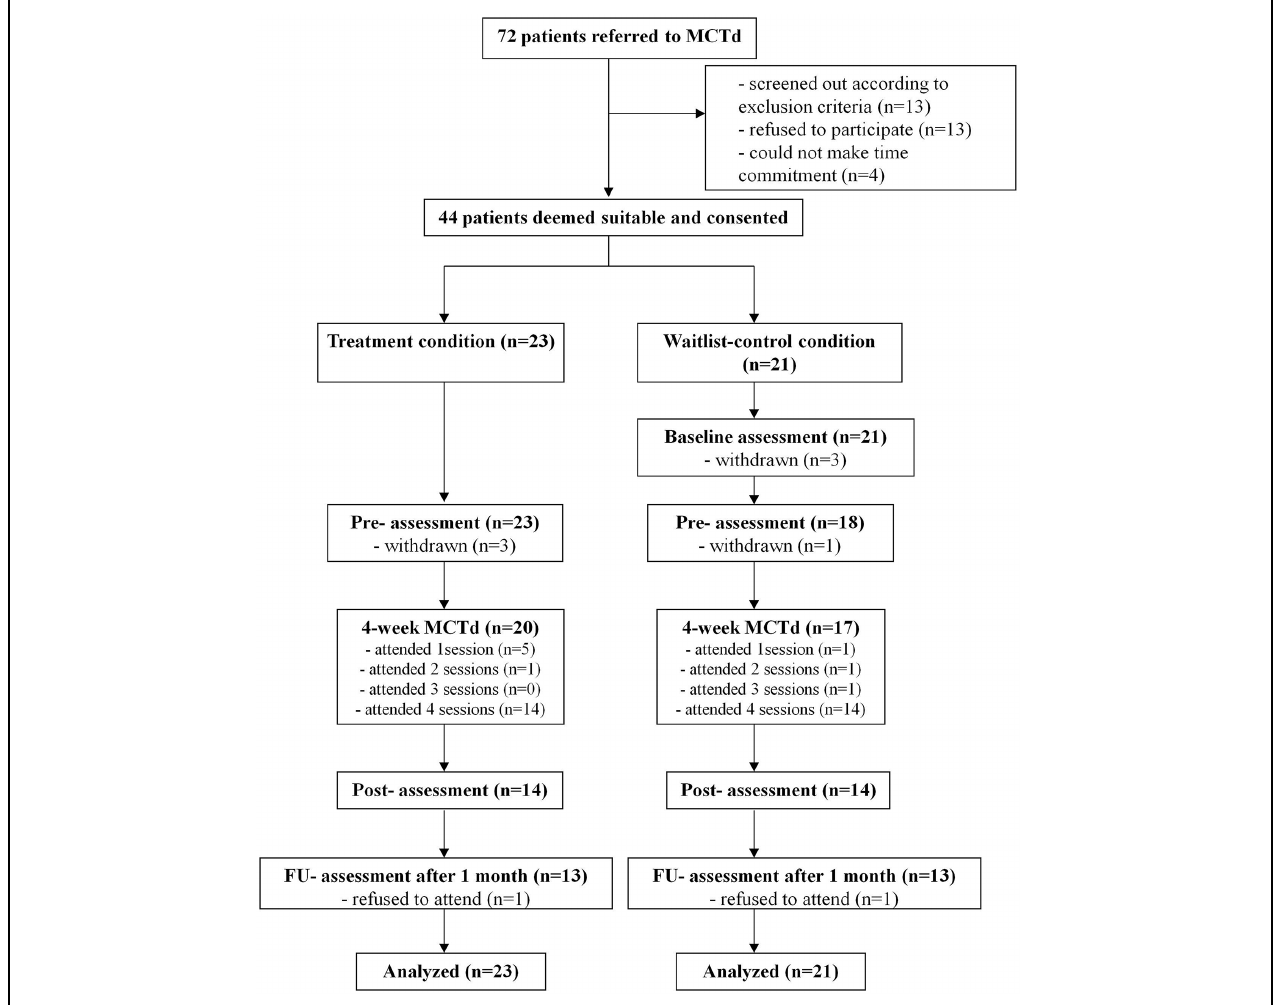
FIGURE 1 | Consort diagram of the study